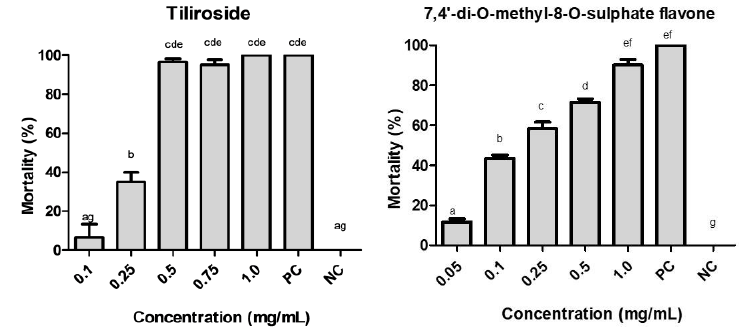
Figure 6. Larvicidal activity of the isolated substances of H. velutina, tiliroside after 72 h and 7,4′-di- O -methyl-8- O -sulphate flavone after 24 h. PC = positive control, NC = negative control. Bars with the same letter are not significantly different as determined by Tukey test, 5%.